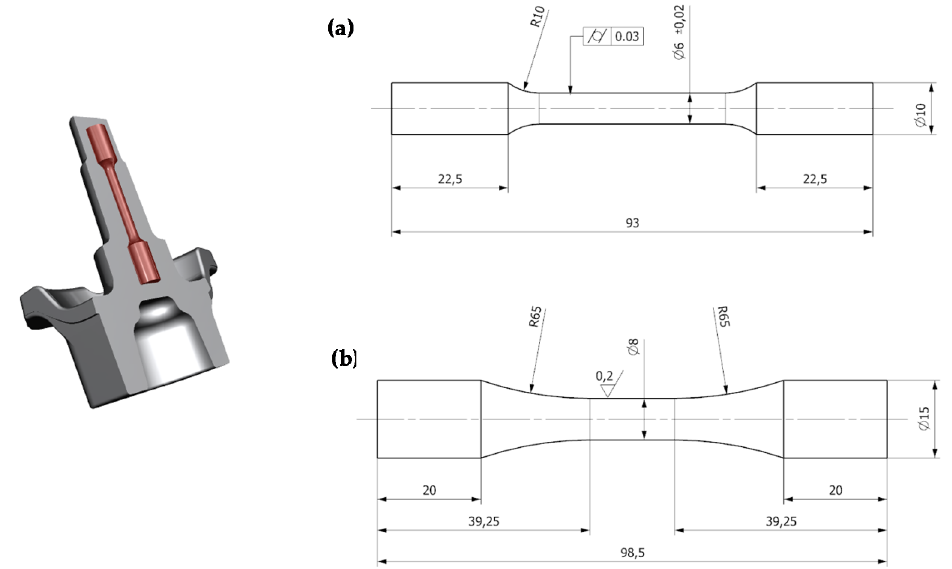
Figure 7. Schematic illustration of the location from which the specimens were taken and the geometry for ( a ) tensile and ( b ) fatigue tests. All dimensions are in mm except the roughness in μ m.